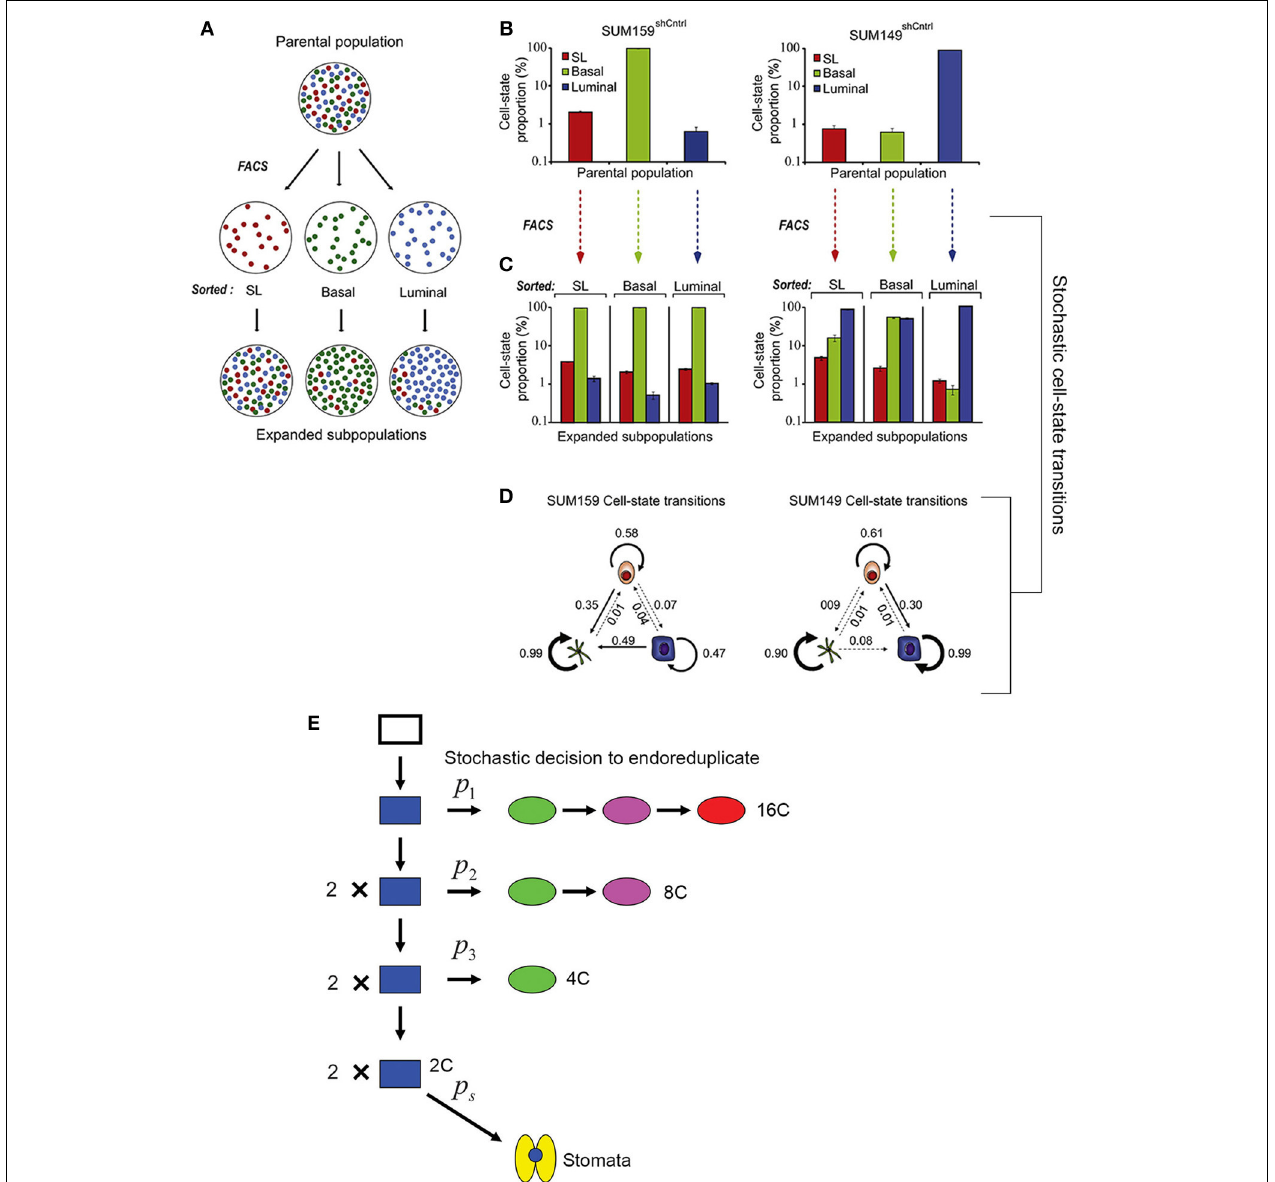
FIGURE 5 | Stochasticity maintains phenotypic diversity in cell populations. (A) Cancer cell subpopulations [stem cell-like cells (SL; red), basal (green), and luminal (blue)] were sorted using fluorescence-activated cell sorting (FACS) to isolate cell type specific populations. After 6 days post-sorting, each of the isolated populations expanded to contain all three cell subtypes, suggesting that all three cell types can interconvert stochastically between different cell states. (B) Graph showing the proportion of SL, basal, and luminal cells in two cancer cell lines before sorting. (C) Cells were FACS sorted to produce populations with a single pure cell type. The graph shows the that 6 days after sorting the proportion of SL, basal, and luminal cells in each of these populations has returned nearly to the starting proportions. (D) Schematic diagrams depicting the stochastic cell state transitions between cell types for each cell line. Reprinted from Cell, 146/4, Gupta et al. (2011) Copyright, with permission from Elsevier. (E) A probabilistic model for the